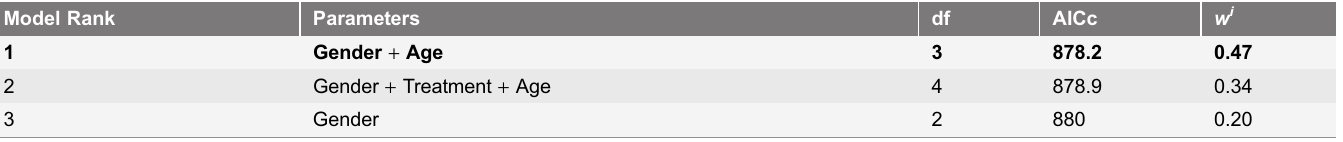
Table 6. GLM to investigate factors affecting probability that Player 1 would give nothing to Player 2.